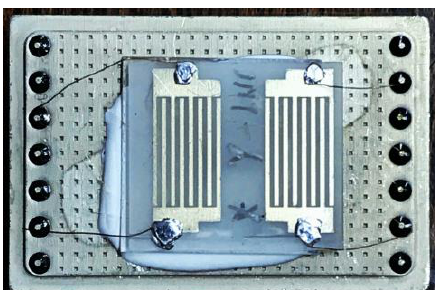
Fig. 3. The photo of ink-printed delay line formed as chip.